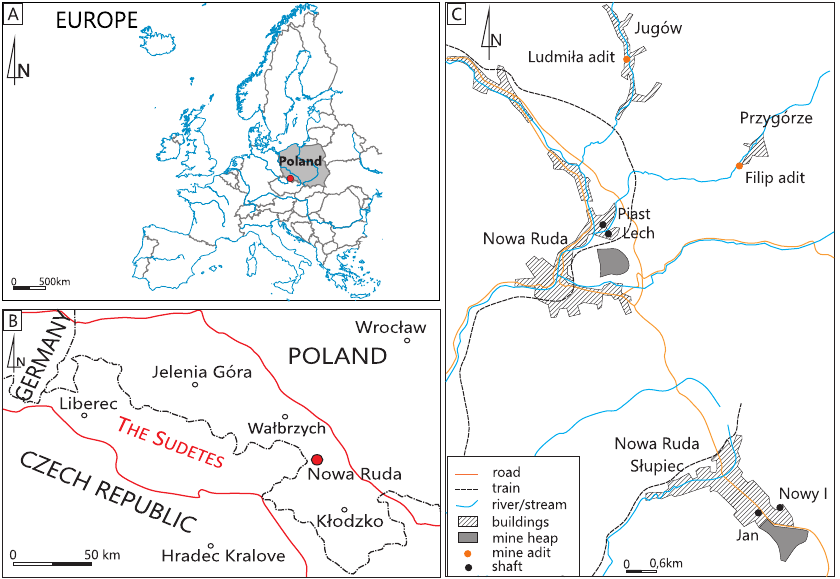
Figure 1. Localization of the study area ( A ) in Europe, ( B ) in the Sudety Mountains, ( C ) in the Nowa Ruda region.